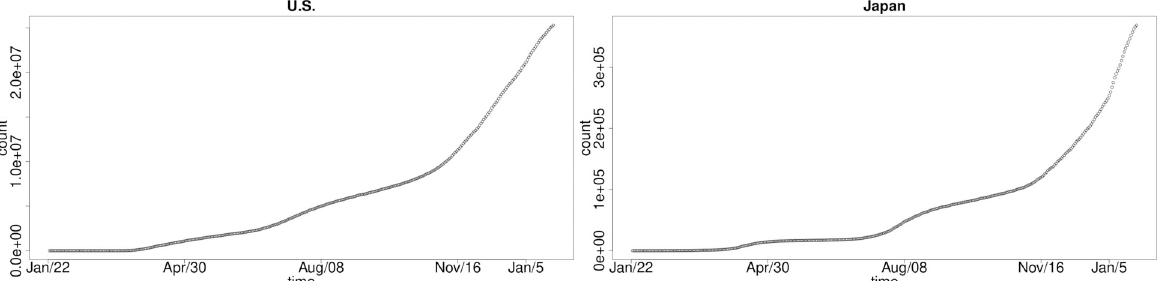
Fig 3. Cumulative COVID-19 national-level infections over time: US (left) and Japan (right).